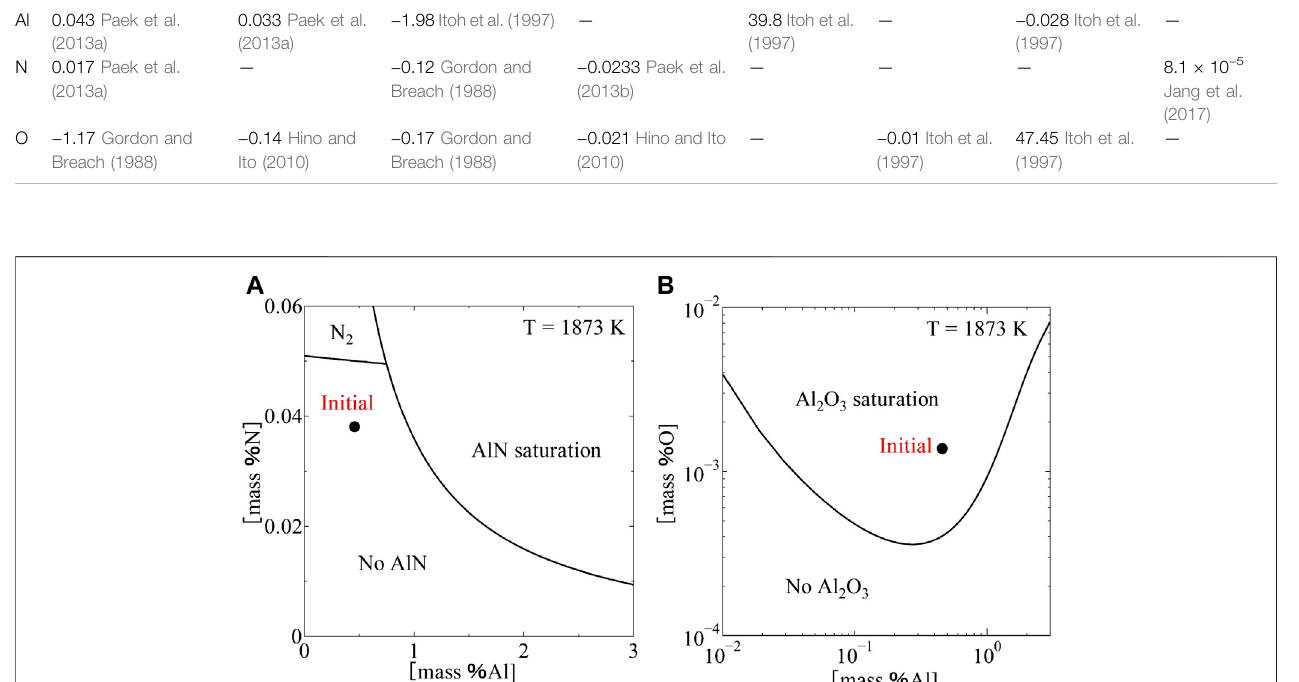
FIGURE 6 | Equilibrium relation between (mass %Al) and (mass %N) (A) , Equilibrium relation between (mass %Al), and (mass %O) (B) , in Fe-Al-2.0Mn system at 1873 K.